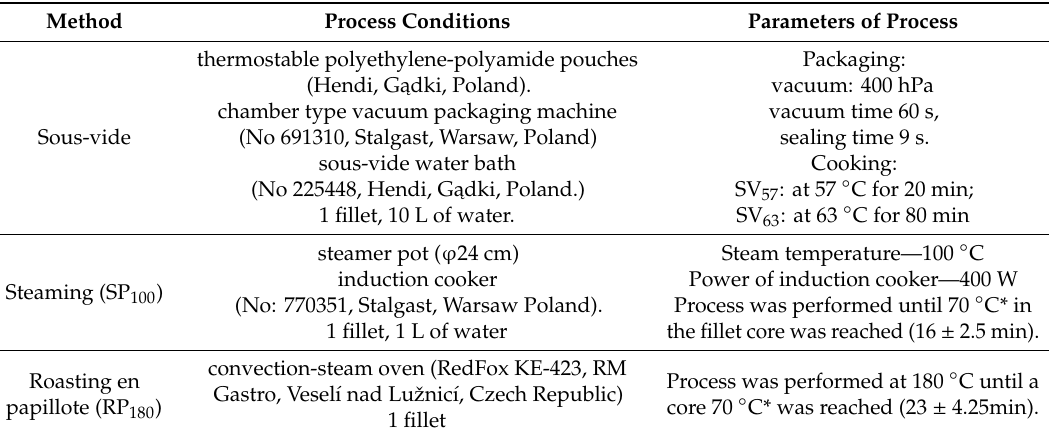
Table 1. Characteristics of evaluated salmon’ cooking